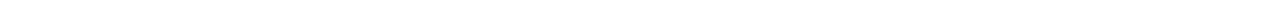
Fig. 2 Ectopic Brd affects recruitment of apical MyoII. a Time-course accumulation of apical MyoII (total intensity in arbitray units (A.U.)) in ventral cells of one representative wild-type (green, n = 3) and sna > Brd R embryos (blue, n = 3). Mean and s.e.m. values are shown (see complete data set in Supplementary Fig. 3a). In this and other panels, the onset of apical constriction ( t = 0) is indicated with a gray bar. b , c Apical MyoII-GFP levels (green) increased sharply as ventral cells constricted (surface area in pixels, blue) in wild-type embryos ( b ). Over-expression of m α and Tom led to slow MyoII increase and delayed constriction ( c ). One representative embryo is shown (see complete data set in Supplementary Fig. 3b). d , e Snapshots of MyoII-GFP (green) and Gap43-Cherry (red) movies of wild-type ( d ) and mat > m α + Tom ( e ) embryos. A dense myosin meshwork running across cell – cell boundaries was observed in wild-type embryos ( d ), whereas apical MyoII organized in a loose network in mat > m α + Tom embryos e . Anterior is up. f , g Cumulative distribution of MyoII pulses ( f ) and box plots of pulse amplitude values ( g ) in wild-type ( n = 190 pulses, 79 cells in three embryos over 10.3 min) and mat > m α + Tom embryos ( n = 390, 85 cells in three embryos over 33.6 min). MyoII pulses just precede furrow invagination in wild-type embryos, whereas these were distributed over ~30 min in mat > m α + Tom embryos ( f ). Also, higher amplitude pulses were seen in wild-type embryos ( g , p = 0.004). In these and all other Tukey box plots, whiskers extend to the highest and lowest values that are within 1.5 inter-quartile range and dots are outlier values. h ,